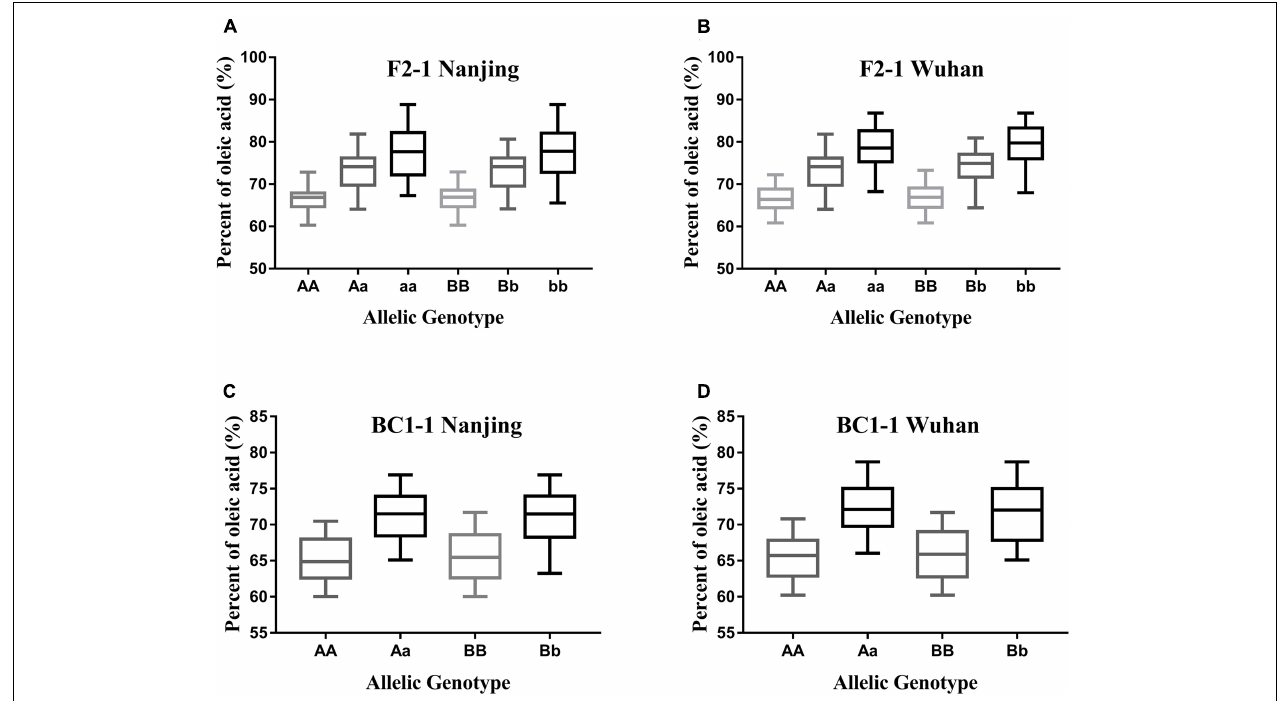
FIGURE 6 | Distribution of the oleic acid content for lines with different allelic genotypes in the segregation populations. Genotype effects mediated by the BnFAD2-1 (three genotypes: AA, Aa, and aa) and BnFAD2-2 (three genotypes: BB, Bb, and bb) genes are shown for the F2 population (A,B) and BC1 population (C,D) at two sites (Nanjing and